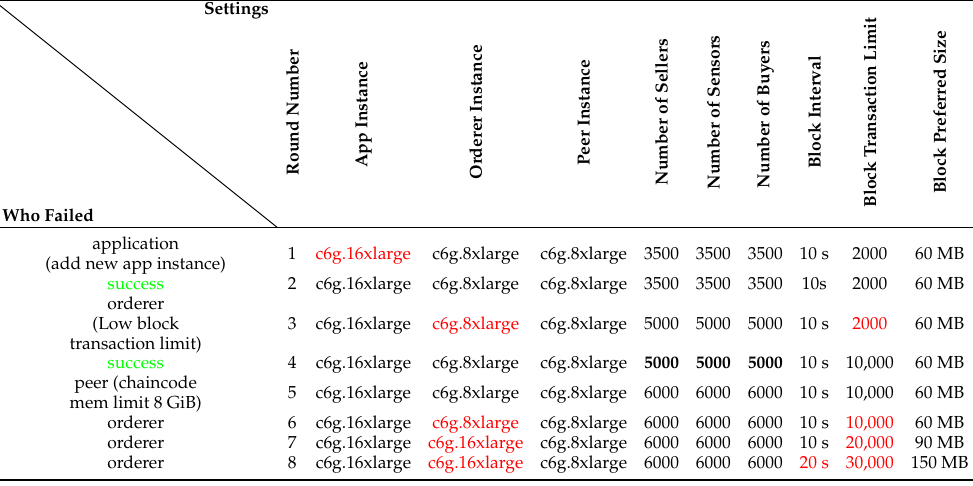
Table 4. Round configurations in Phase 3. The instances which indicated failure are highlighted in red, while green highlight the successful rounds.